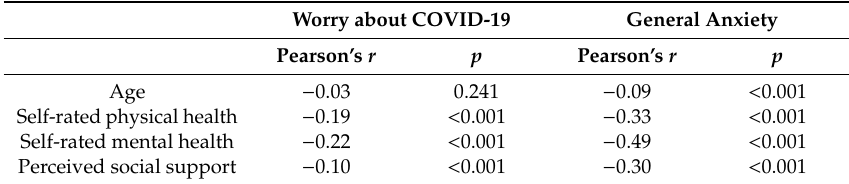
Table 3. Correlations of age, self-rated physical and mental health, social support, and confidence in COVID-19 management ability with worry toward COVID-19 and general anxiety.